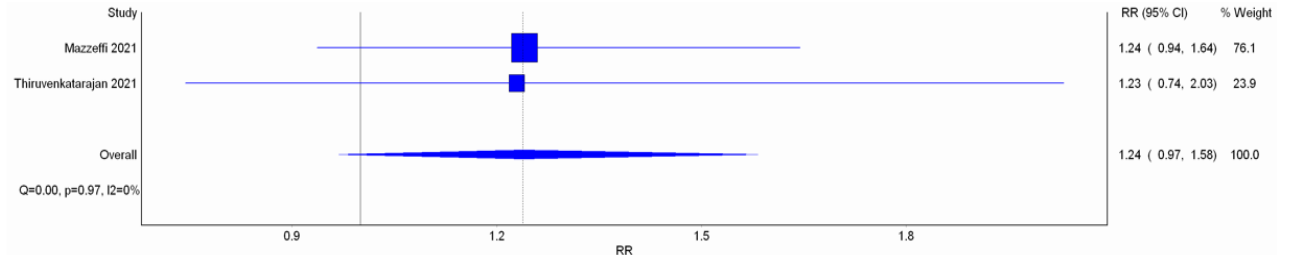
Figure A6. Meta-analysis with IVhet model: incidence of hypercapnia. Studies included: Mazzeffi et al. [14] Thiruvenkatarajan et al. [15].